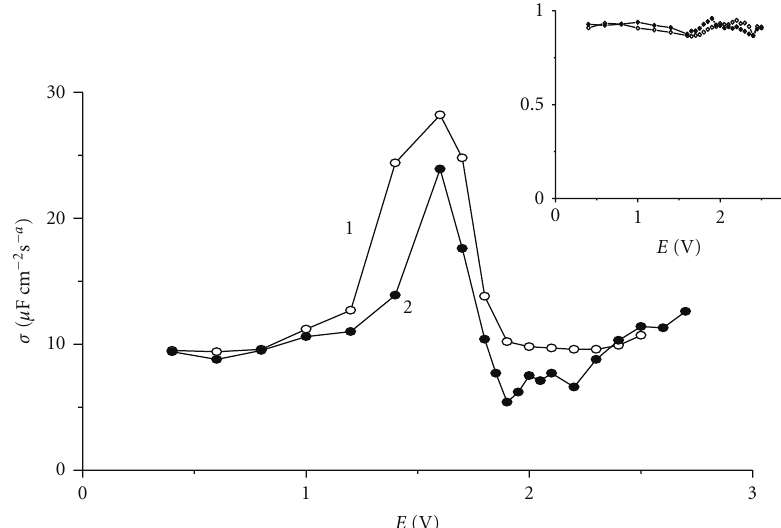
Figure 6: Potential dependence of σ and a (inset): (1) benzene-containing solution; (2) benzene-free solution.